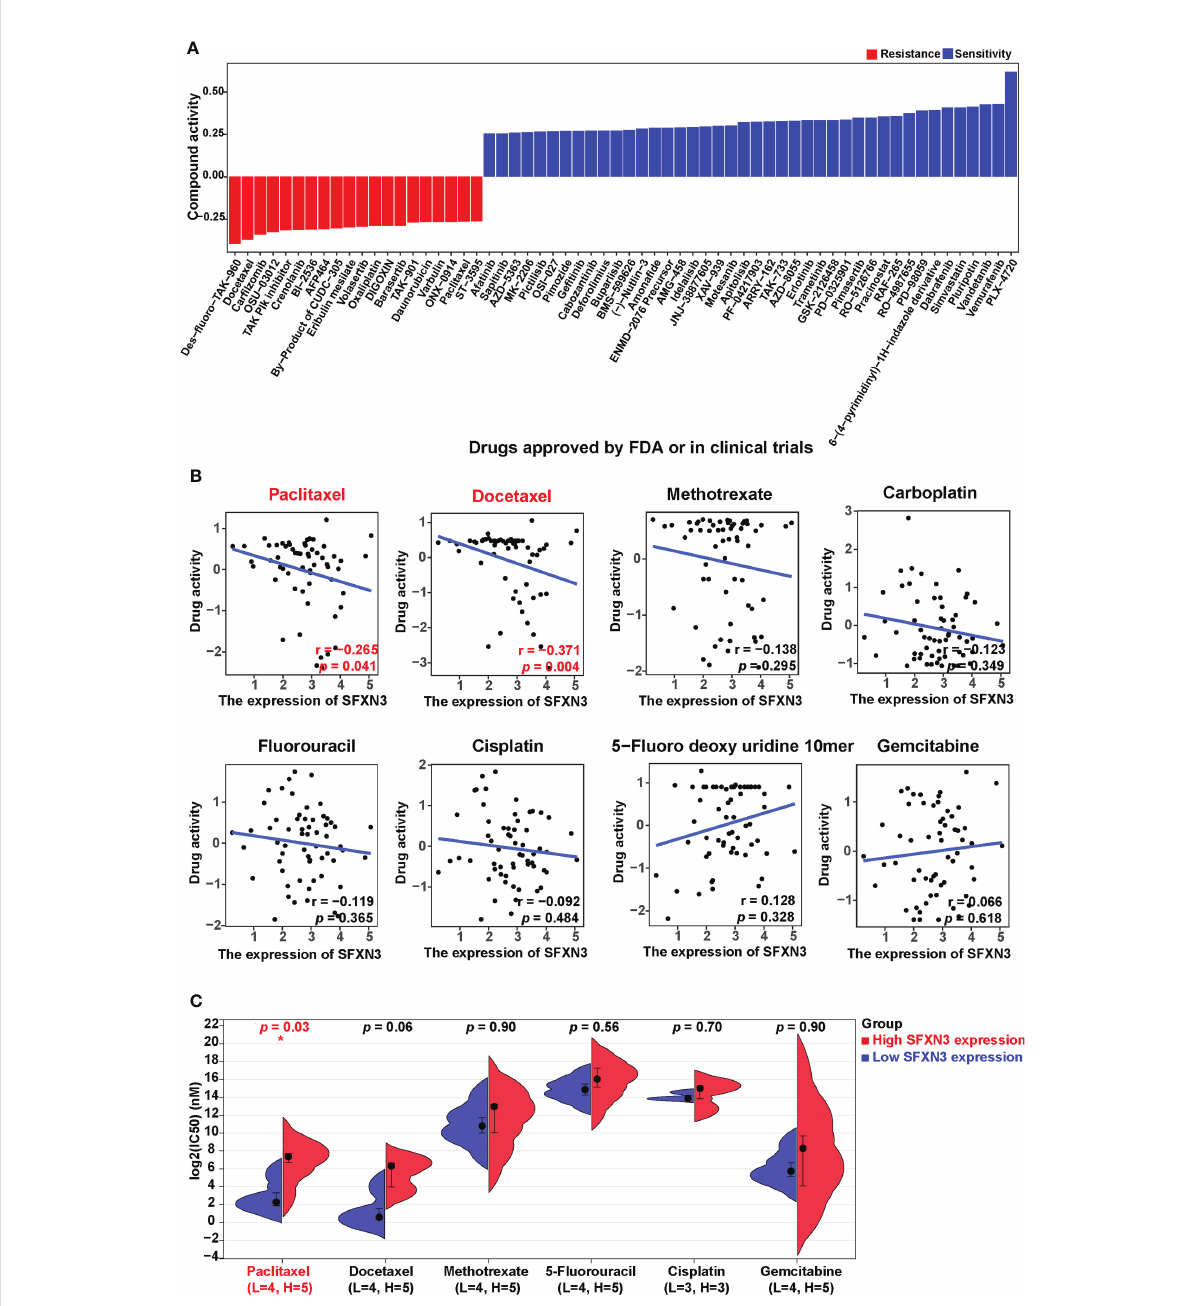
FIGURE 5 SFXN3 expression as a potential predictor for drug sensitivity. (A) The compound activity z scores of chosen compounds in relation to SFXN3 expression, as shown by correlation analysis. (B) Correlation analysis using the Spearman correlation test for SFXN3 expression and activity z scores of paclitaxel, docetaxel, paclitaxel, methotrexate, carboplatin, fl uorouracil, cisplatin, 5- fl uoro deoxy uridine 10mer, and gemcitabine. (C) IC50 values of chemotherapeutics, including paclitaxel, docetaxel, methotrexate, 5- fl uorouracil, cisplatin, and gemcitabine in the high SFXN3 expression HNSC cell lines compared with those in the low SFXN3 expression HNSC cell lines. HNSC cell lines with high SFXN3 expression were found to possess higher IC50 for docetaxel. The p -values were calculated using the Wilcoxon rank-sum test. * p value <